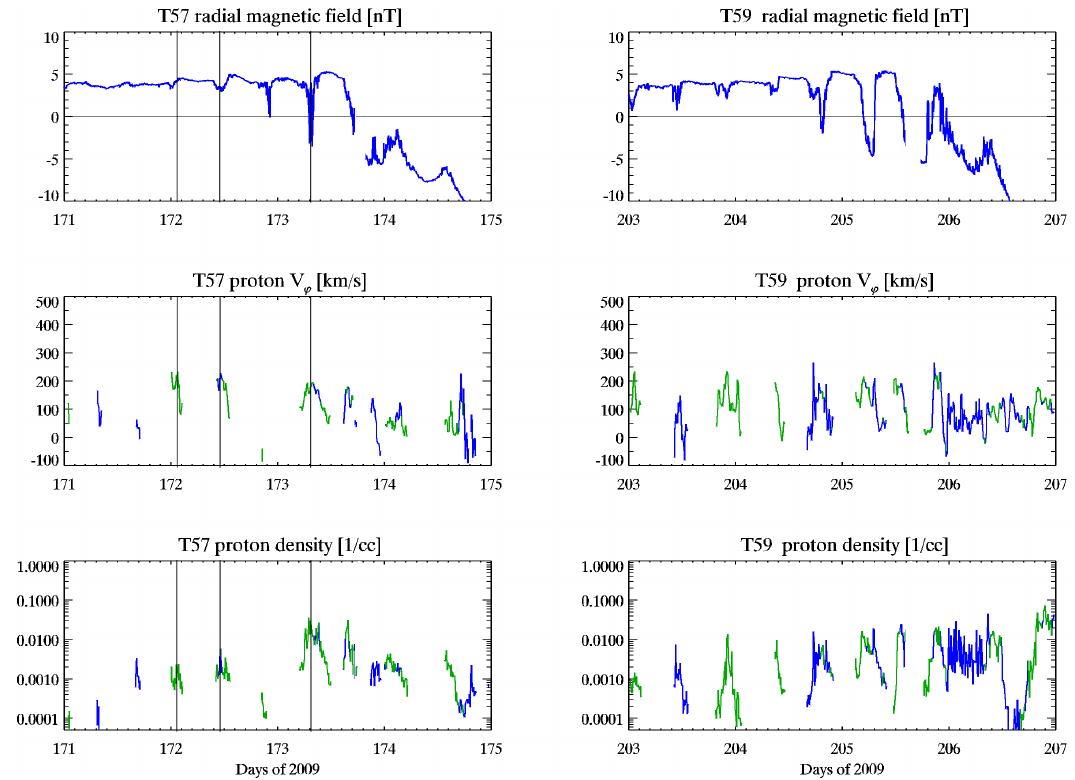
Figure 1. Radial magnetic field (top panel), azimuthal velocity (middle panel) and proton density (bottom panel) for two 4-day long orbit segments containing the T57 (on the left) and T59 (on the right) Titan encounters.